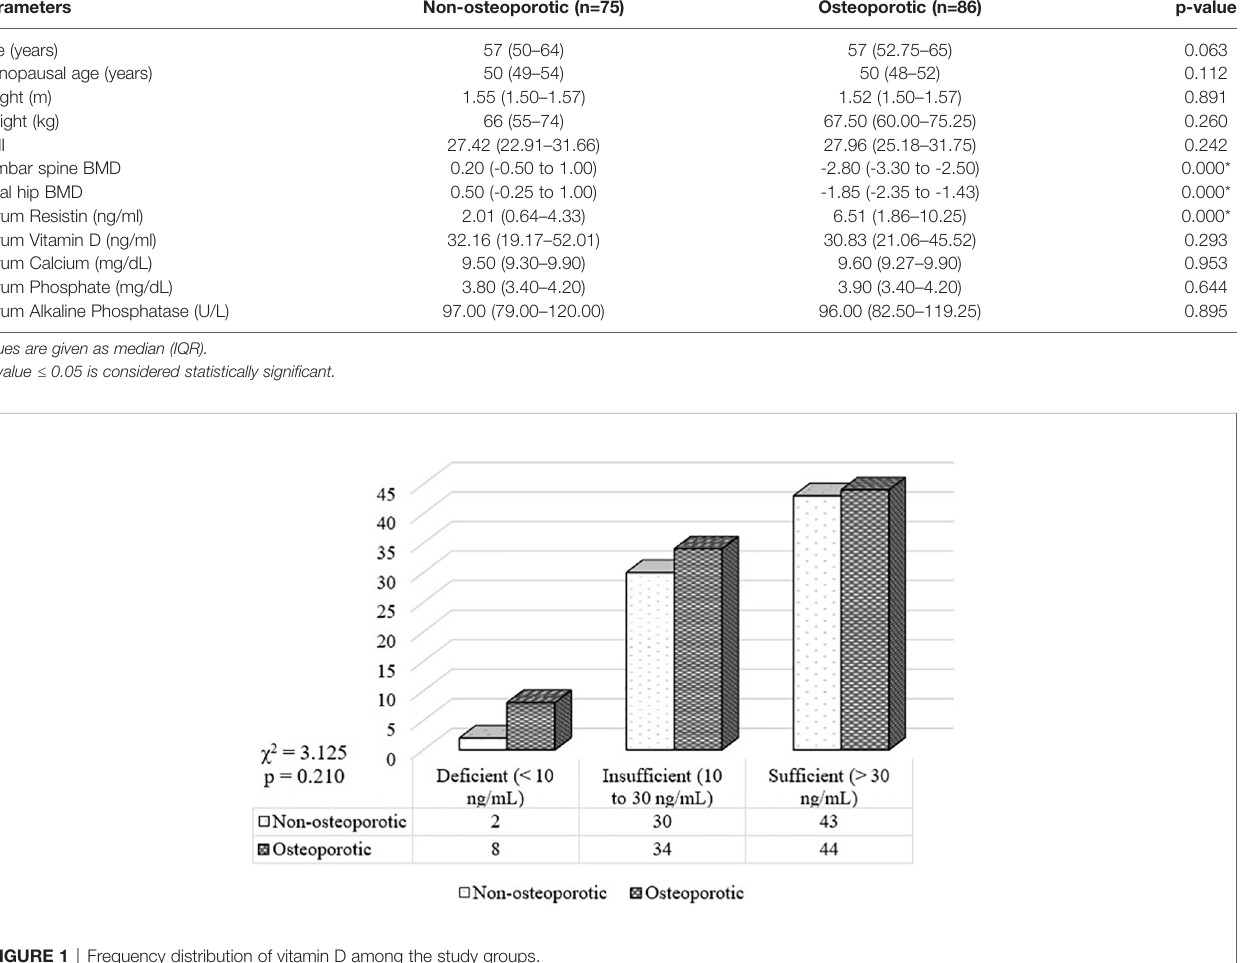
FIGURE 1 | Frequency distribution of vitamin D among the study